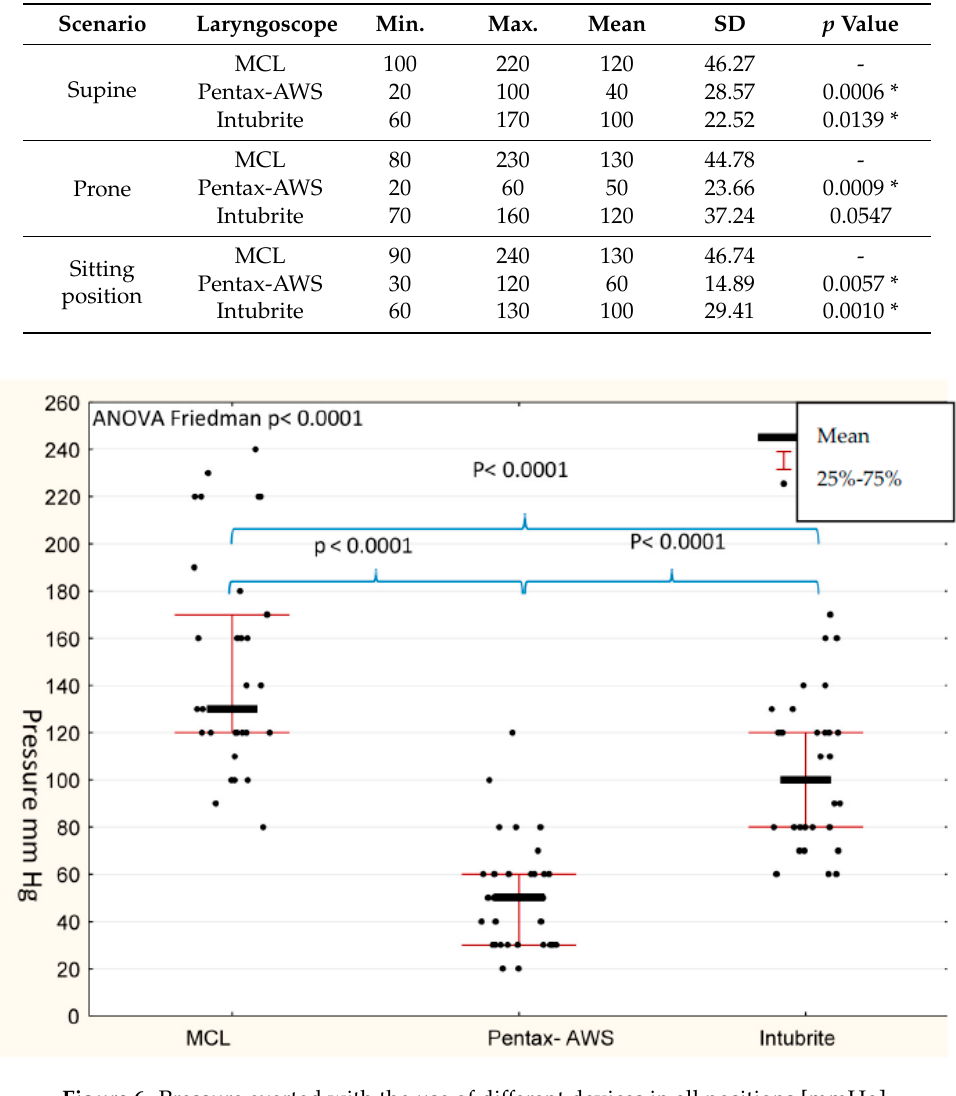
Figure 6. Pressure exerted with the use of different devices in all positions [mmHg]. Table 3. Pressure created on the tongue during intubation in simulated different positions [mmHg]. (Min ‐ minimum, Max ‐ maximum, SD ‐ standard deviation). MCL ‐ Macintosh Laryngoscope, * p value when compared with the MCL (control